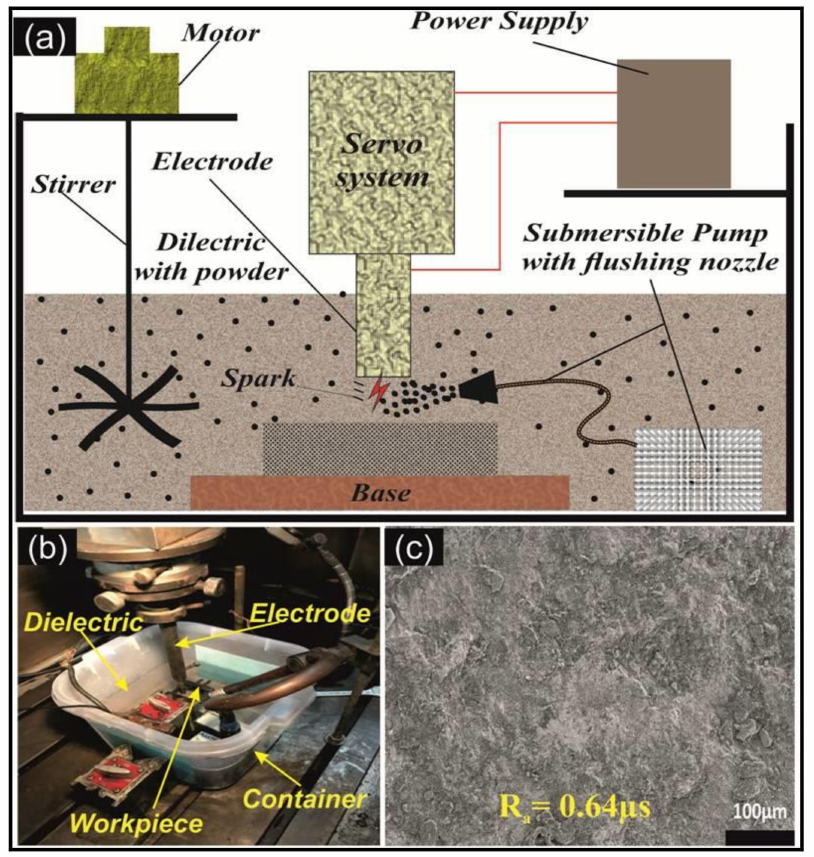
Figure 1. ( a ) Schematic arrangement of EDM; ( b ) Pictorial view of experimental set up of machining; ( c ) FE-SEM image of un-machined DSS-2205 substrate (Ra = 0.64 µ